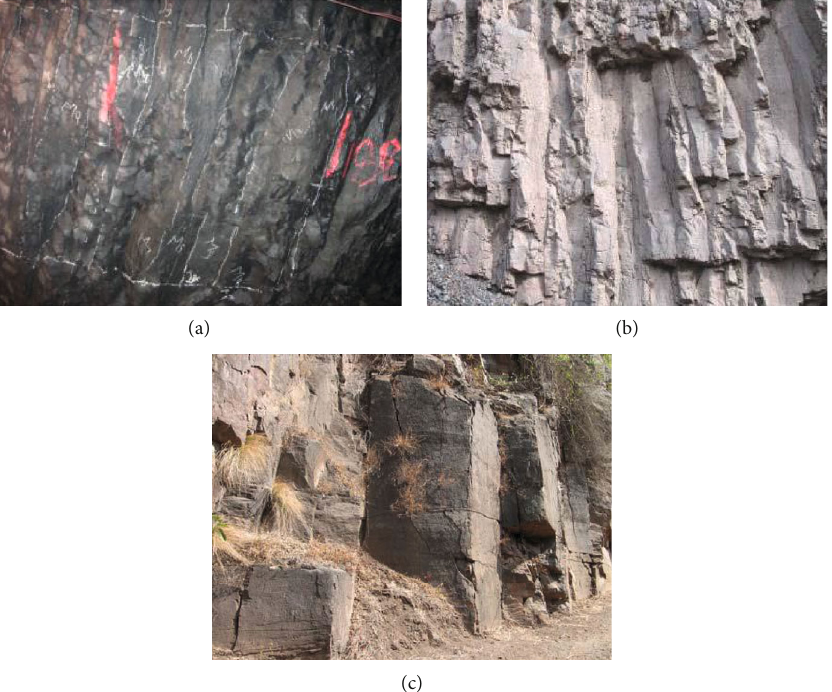
Figure 5: Typical columnar jointed rock mass: (a) Type I, (b) Type II, and (c) Type